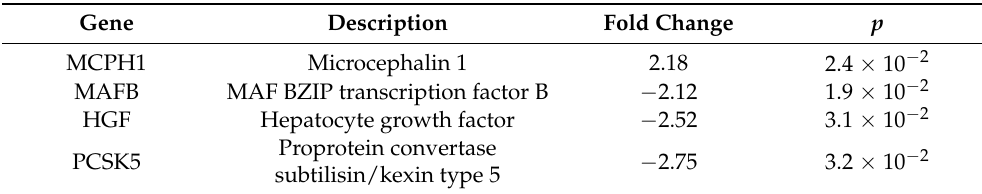
Table 7. Intraocular Pressure-Associated Genes Differentially Expressed in Cyclically Stretched Human Trabecular Meshwork Cells.